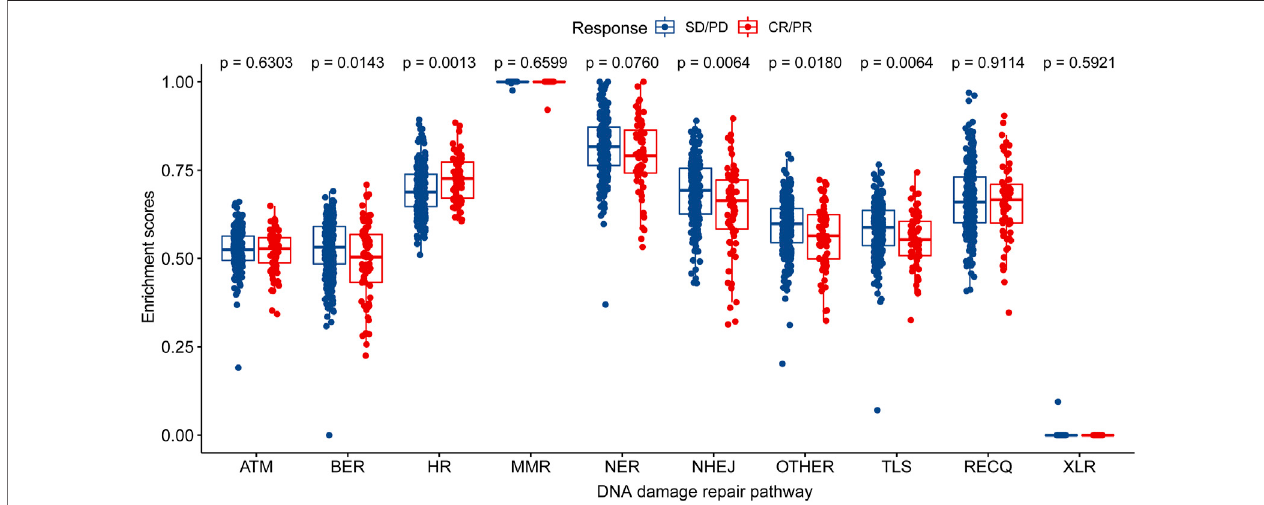
FIGURE 2 | Distribution of enrichment scores of DNA damage repair pathway in CR/PR group and SD/PD group. ATM, ataxia telangiectasia mutated; BER, base excision repair; FA/HR, Fanconi Anemia/homologous recombination; MMR, mismatch repair; NER, nucleotide excision repair; NHEJ, non-homologous end joining; OTHER, other; TLS, translesion synthesis; RECQ, recQ helicase pathway; XLR, cross-link repair; CR/PR, complete response/partial response; SD/PD, stable disease/ progressive